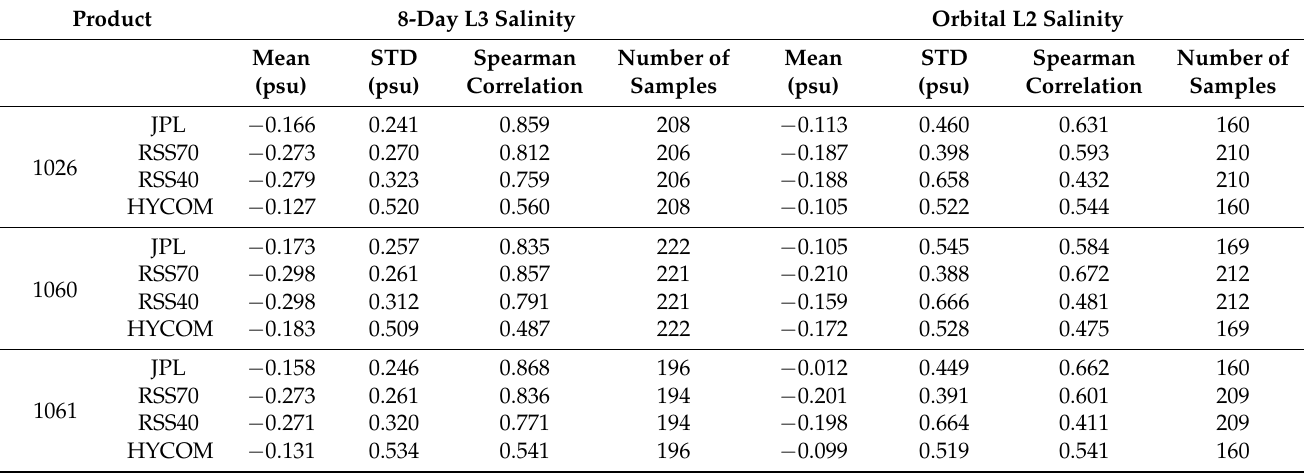
Table 2. Mean difference and standard deviation difference (STD) for saildrone minus satellite and HYCOM data, as well as Spearman correlation coefficient from saildrone and